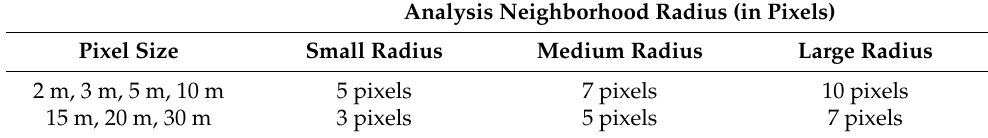
Table 1. Neighborhood sizes depending on the image pixel